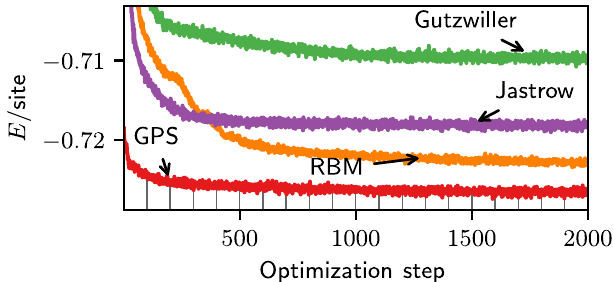
FIG. 8. Convergence of the ground-state energy for the 8 × 8 Hubbard model, at U ¼ 8 t and with 0.875 electrons per site. The bootstrapped GPS representation is initialized at the optimized Jastrow wave function, resulting in rapid convergence. Vertical grey lines indicate the iterations at which the configurational data set of the GPS is updated. The convergence is shown for Gutzwiller (1 parameter), Jastrow (34 parameters), the RBM with α ¼ 16 (2064 parameters), and the bootstrapped GPS with 63 parameters). The number of optimized distance weights ( N b þ data configurations specifying the GPS after each application of the RVM in the algorithm range from about 1000 to 2000